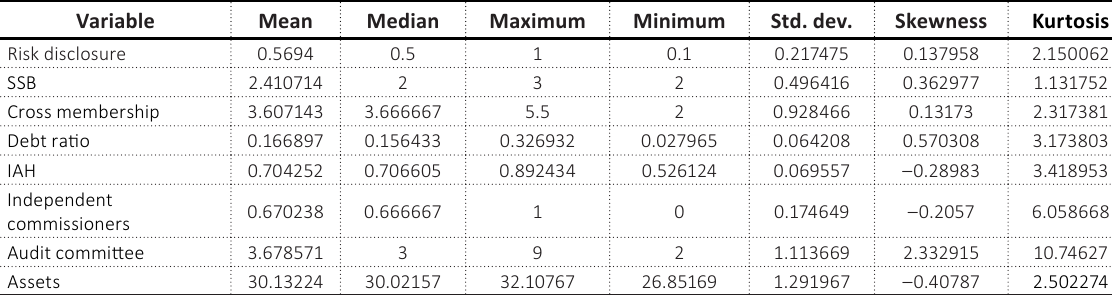
Table 2. Results of the descriptive test